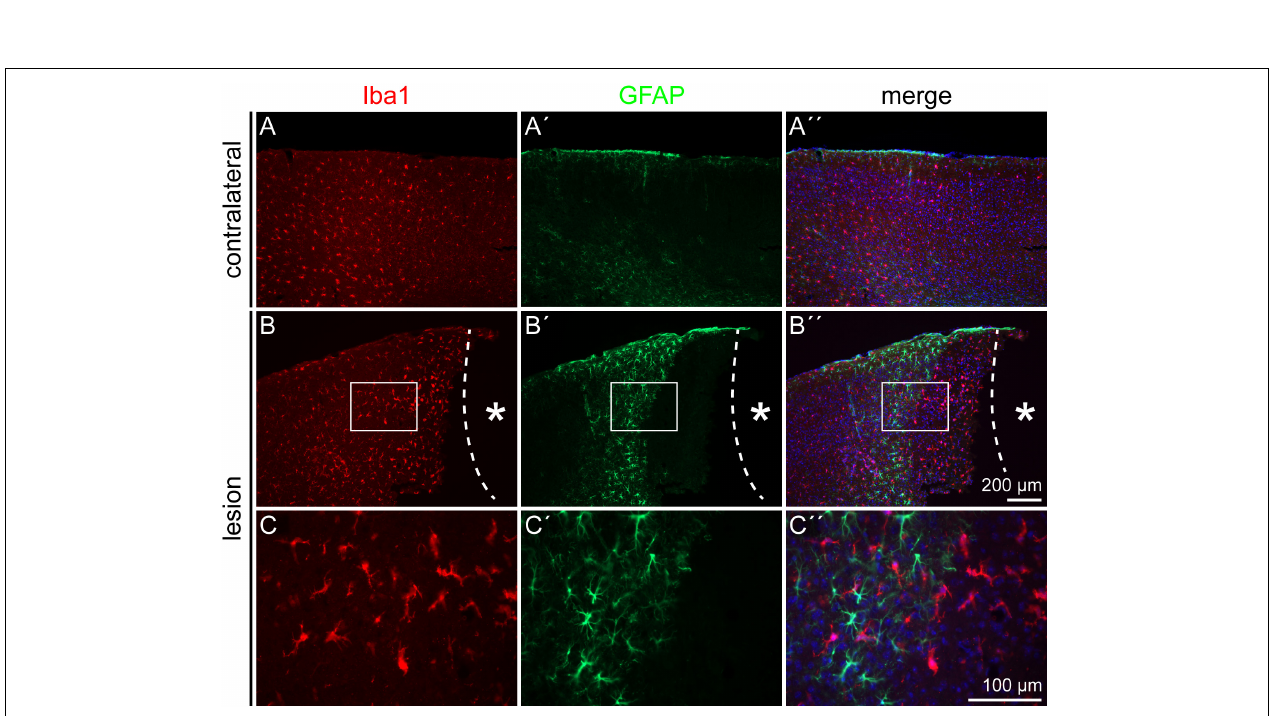
FIGURE 2 | Microglia and astrocyte distribution after lesion, 3 dpl. Iba1 staining showed no colocalization with the GFAP signal. As on the contralateral side (A–A (cid:48)(cid:48) ) , Iba1-positive microglia were distributed also throughout the cortex in the penumbra (B–B (cid:48)(cid:48) ) . GFAP-positive astrocytes kept a distance of more than 300 µ m from the lesion core, whereas Iba1-positive microglia could be found directly adjacent to it. (C–C (cid:48)(cid:48) ) Show higher magnifications of the boxes in (B–B (cid:48)(cid:48) ) . Asterisk: lesion core; scale bars: 200 µ m (A–B (cid:48)(cid:48) ) , 100 µ m (C–C (cid:48)(cid:48) ) .